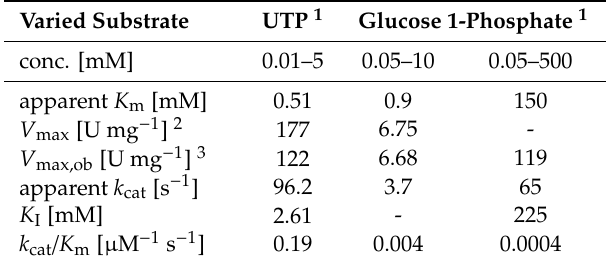
Table 1. Kinetic properties of Ro GalU2. Varied Substrate UTP 1 Glucose 1-Phosphate